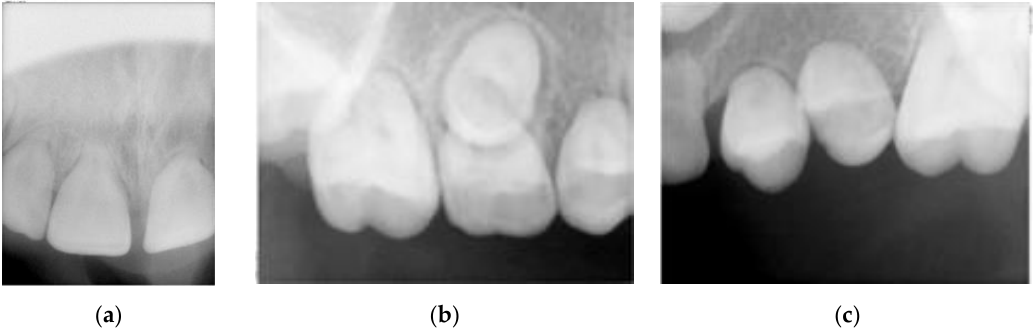
Figure 3. Periapical upper arch x-rays. ( a ) Teeth 1.1 (left) and 2.1 (right); ( b ) First quadrant with 1.4, 5.5 and 1.6 roots missing; ( c ) Second quadrant with 2.4, 2.5 and 2.6 roots missing.